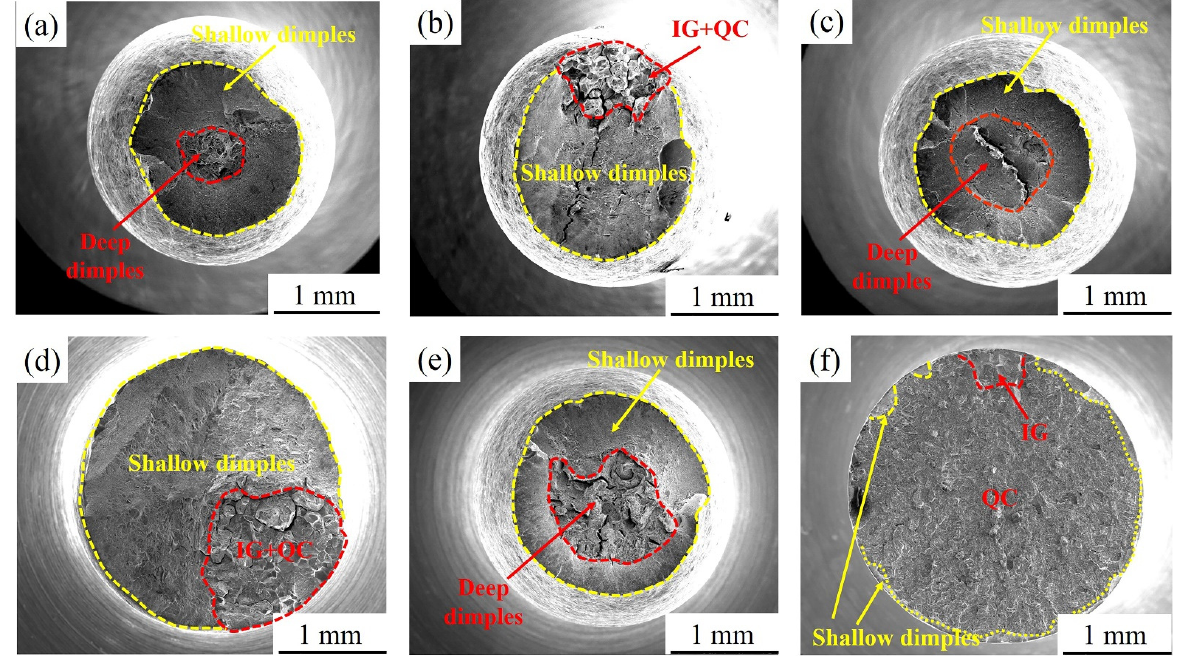
Figure 11. Fracture morphology of the specimens aged at 480 °C for various holding times after SSRTs in air and 3.5 wt.% NaCl solution: ( a ) air, 480A-0.5; ( b ) solution, 480A-0.5; ( c ) air, 480A-4; ( d ) solution, 480A-4; ( e ) air, 480A-80; and ( f ) solution, 480A-80. The fracture morphology of samples aged at 540 °C for different holding times in air and 3.5 wt.% NaCl solution is basically consistent with that of specimens aged at 480 °C, as shown in Figure 12a–f. The difference is that the areas of the fibre zone and shallow dimple zone of 540A-80 in air are larger than 480A-80, indicating that the plasticity of 540A-80 clearly decreases. In addition, at the same